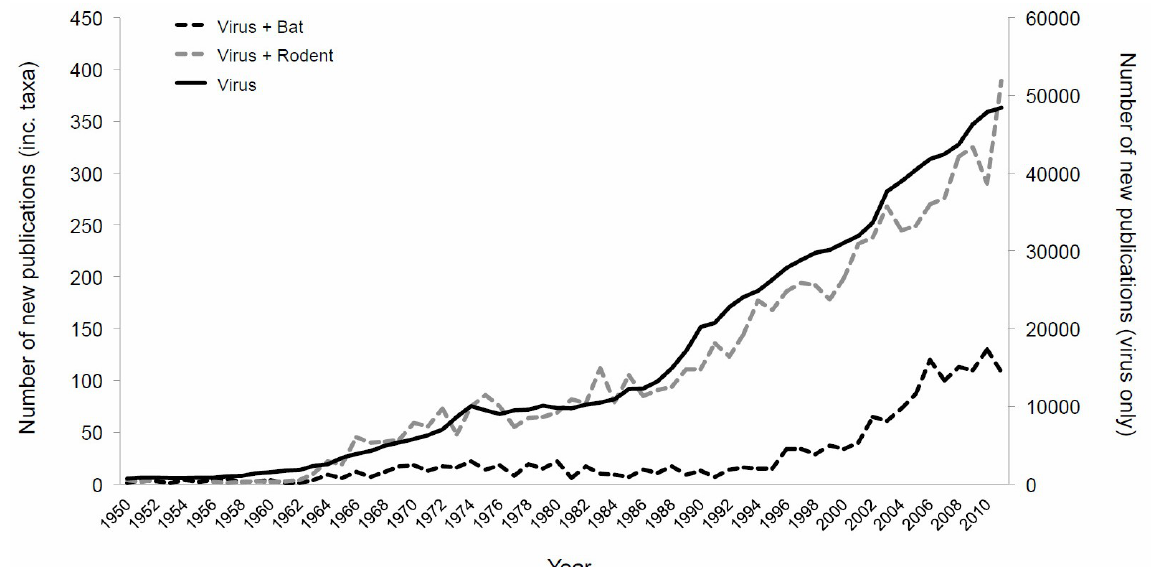
Figure 1. Number of publications recovered from SCOPUS by year when using the search term “virus” with (dashed lines, primary axis) and without (solid line, secondary axis) taxonomic